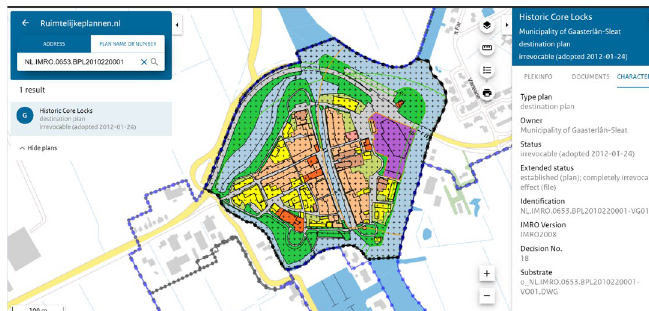
Figure 2. Historic al Core Sloten , Destination Plan , available at the national portal viewer for spatial plans Ruimtelijkeplannen.nl.